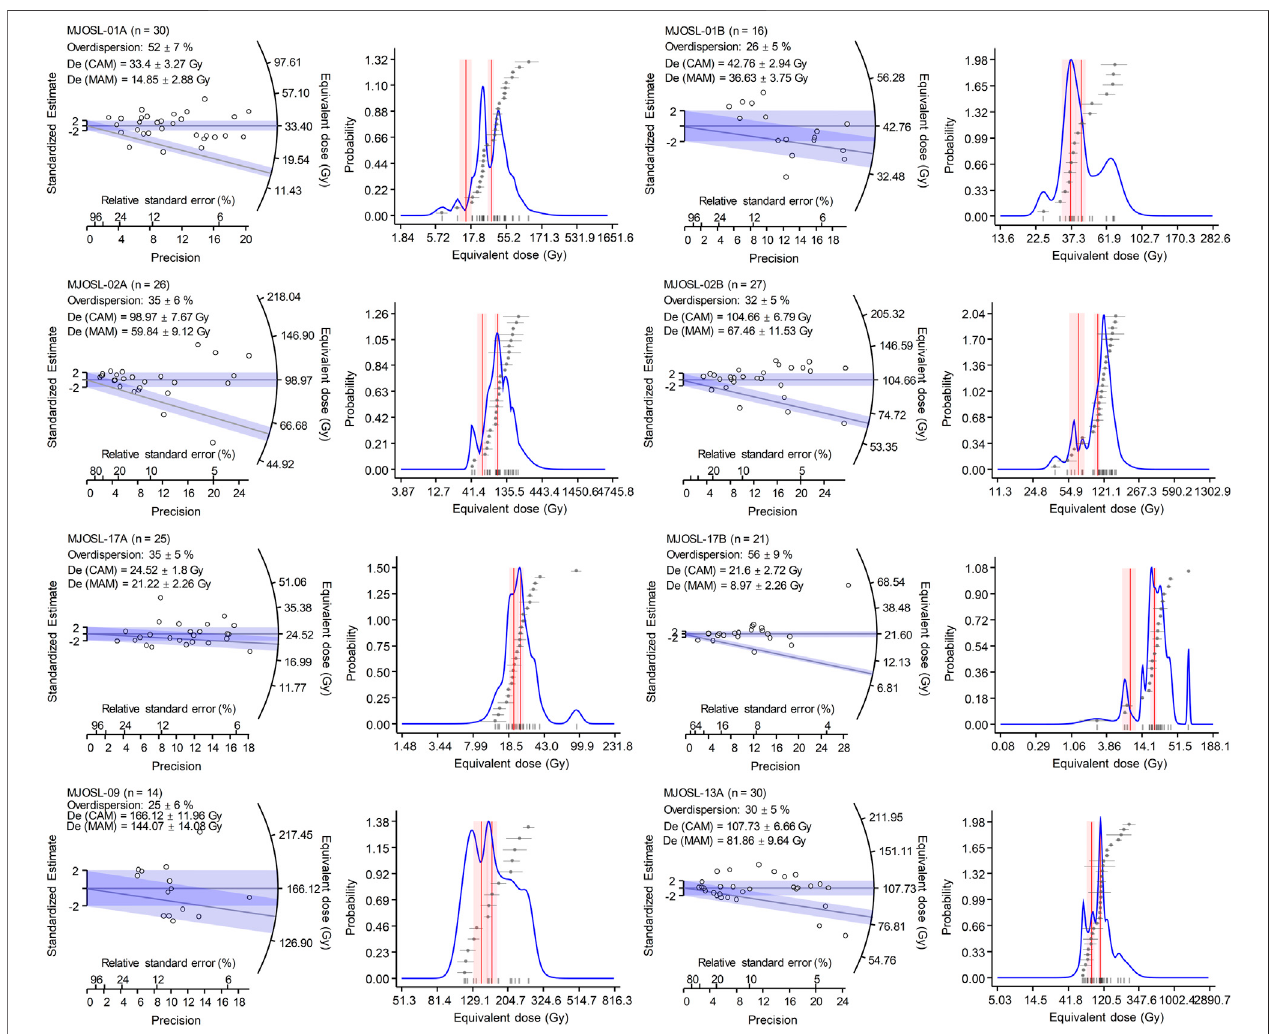
FIGURE 7 | Radial plots and probability density function (pdf) plots showing the D e distributions, which were produced by the LDAC program (V1.0) provided by Liang and Forman (2019). The two shaded areas refer to the 2 σ range for the CAM and MAM D e values.